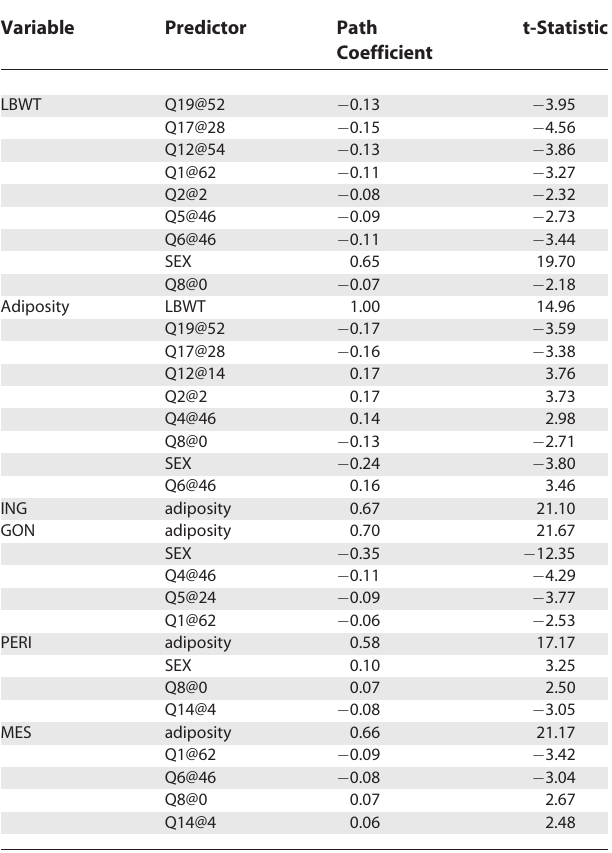
Table 4. Model Assessment and Path Coefficients for the Adiposity SEM Variable Predictor